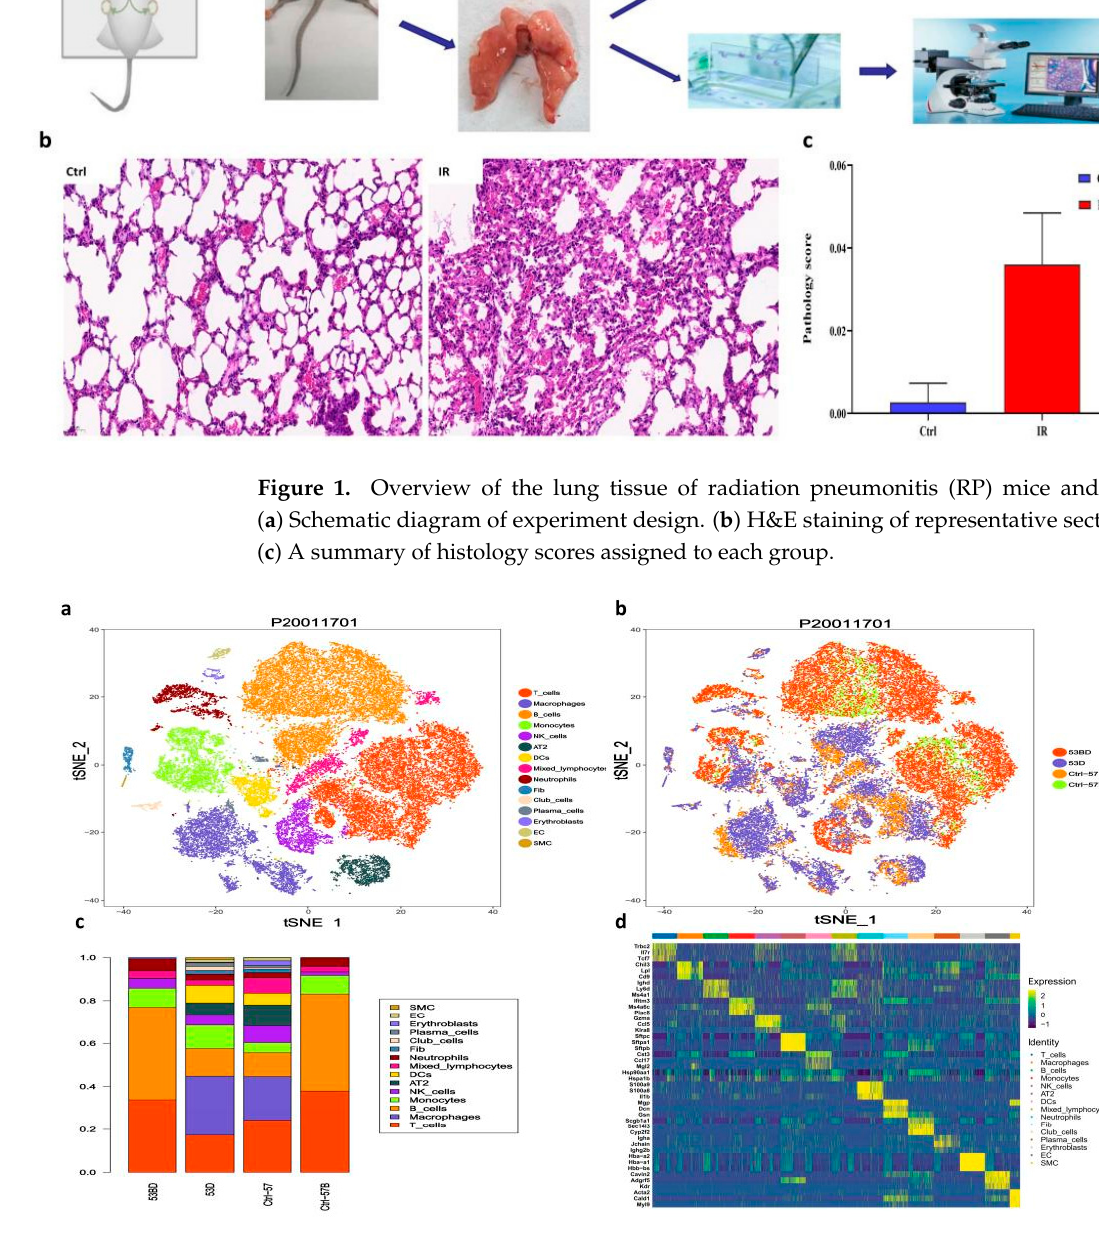
Figure 2. Single-cell transcriptional profiling of the lung tissue and peripheral blood mononuclear cells (PBMC) of radiation pneumonitis (RP) mice and control mice. ( a ) T-SNE for all cell types, including distinct lymphocytes, myeloid cells, type 2 alveolar cells (AT2), fibroblasts, smooth muscle cells, and vascular endothelial cells (VECs). Cell types and samples are indicated on the right. ( b ) The same T-SNE as in ( a ), colored by samples, including (CN, the lung tissue sample from the control mouse); CN-blood, the PBMC sample from the control mouse; RP, the lung tissue samples from the irradiated mice; RP-blood, the PBMC samples from the irradiated mice; ( c ) relative proportion of each cell cluster across 4 samples as indicated. ( d ) Heatmap showing the differentially expressed genes of different clusters, genes, and cells ordered by hierarchical clustering.